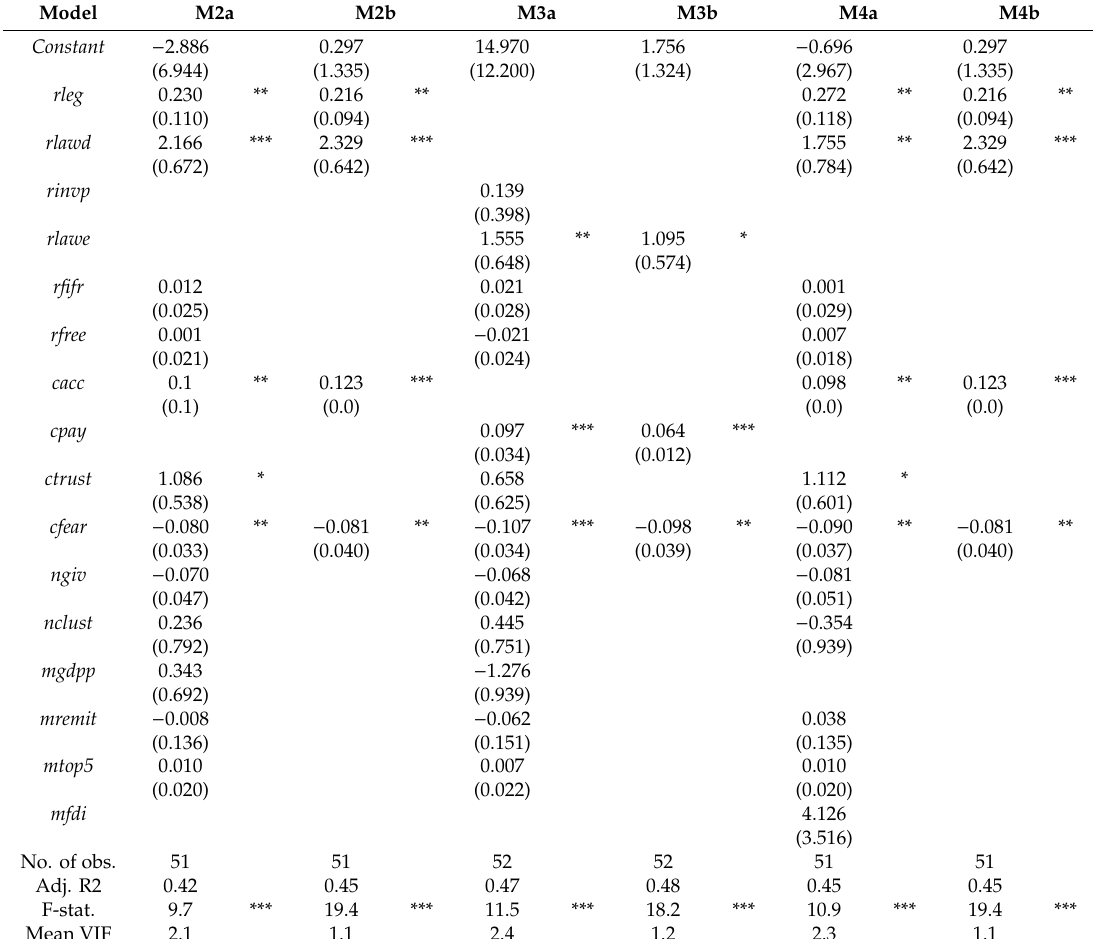
Table A2. All Institutional Determinants of Total Crowdfunding Volumes during 2015–2016 per